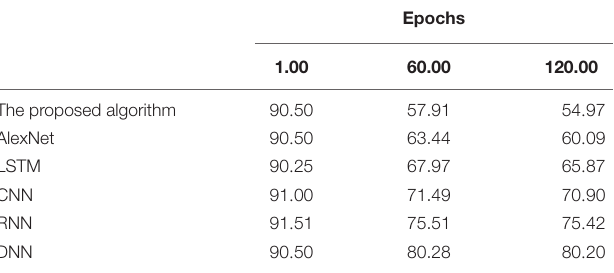
TABLE 1 | Time duration required by different algorithms on the training dataset(s).